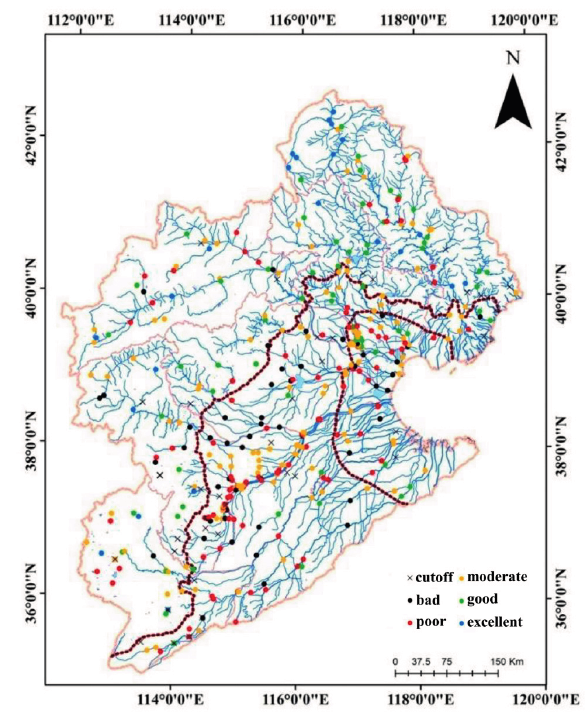
Figure 3. Distribution of RHQ in